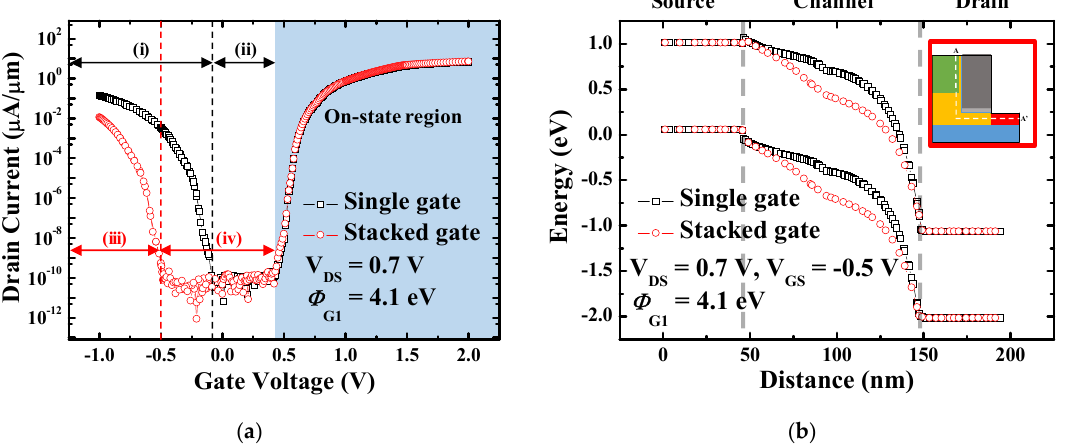
Figure 2. ( a ) Transfer curves of single gate L-shaped TFET and stacked gate L-shaped TFET with 0.7 V-drain voltage ( V DS ). Off-state and ambipolar state region of each device is distinguished by (i)–(iv). Ambipolar state region of the single gate (i), the off-state region of the single gate (ii), ambipolar state region of the stacked gate (iii) and the off-state region of the stacked gate (iv). It is shown that the ambipolar current is suppressed and the ambipolar state region contracts in the stacked gate L-shaped TFET; ( b ) Energy band diagram at gate voltage ( V GS ) = − 0.5 V for single gate L-shaped TFET and stacked gate L-shaped TFET. They are obtained from source-to-drain along the cutline which is indicated in the inset (A-A’). It is presented that the tunneling barrier between channel-to-drain becomes thicker in the stacked gate L-shaped TFET.